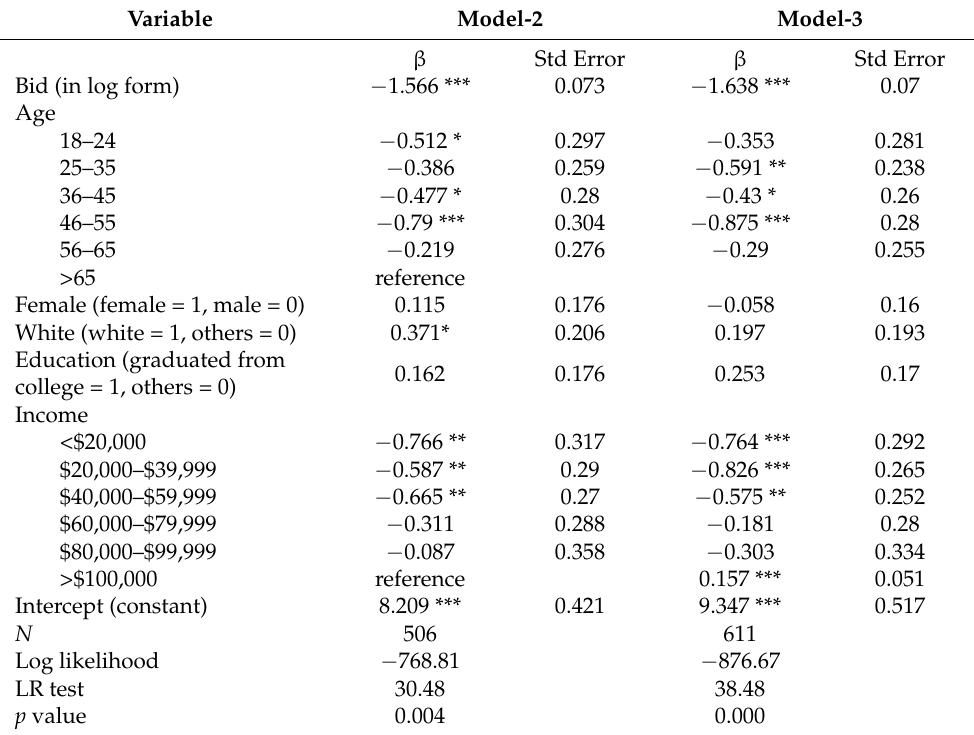
Table A1. Regression results of Model-2 (50% efficacy rate) and Model-3 (95% efficacy